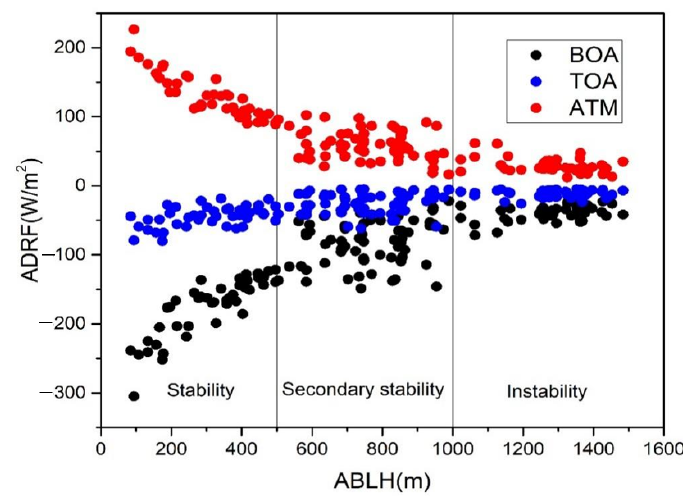
Figure 10. Correlation analysis of ADRF and LHS.